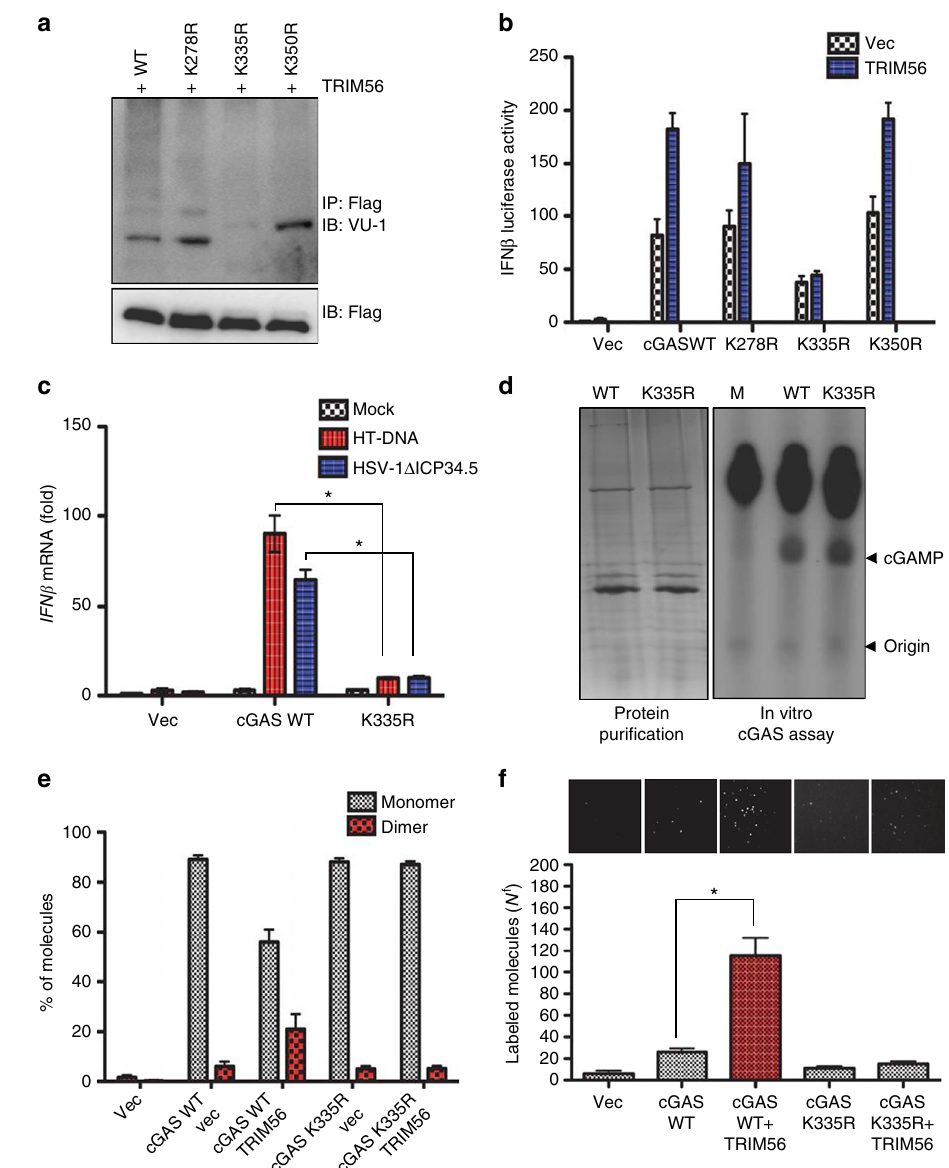
Fig. 4 TRIM56 increases cGAS dimerization and DNA-binding ability. a HEK293T cells were transfected with cGAS WT or cGAS K → R mutants. WCLs